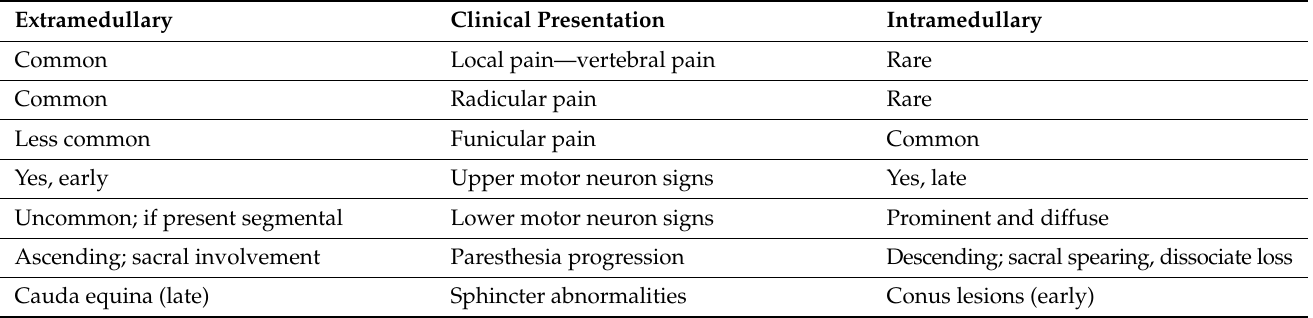
Table 3. Clinical presentation of extramedullary versus intramedullary spinal cord